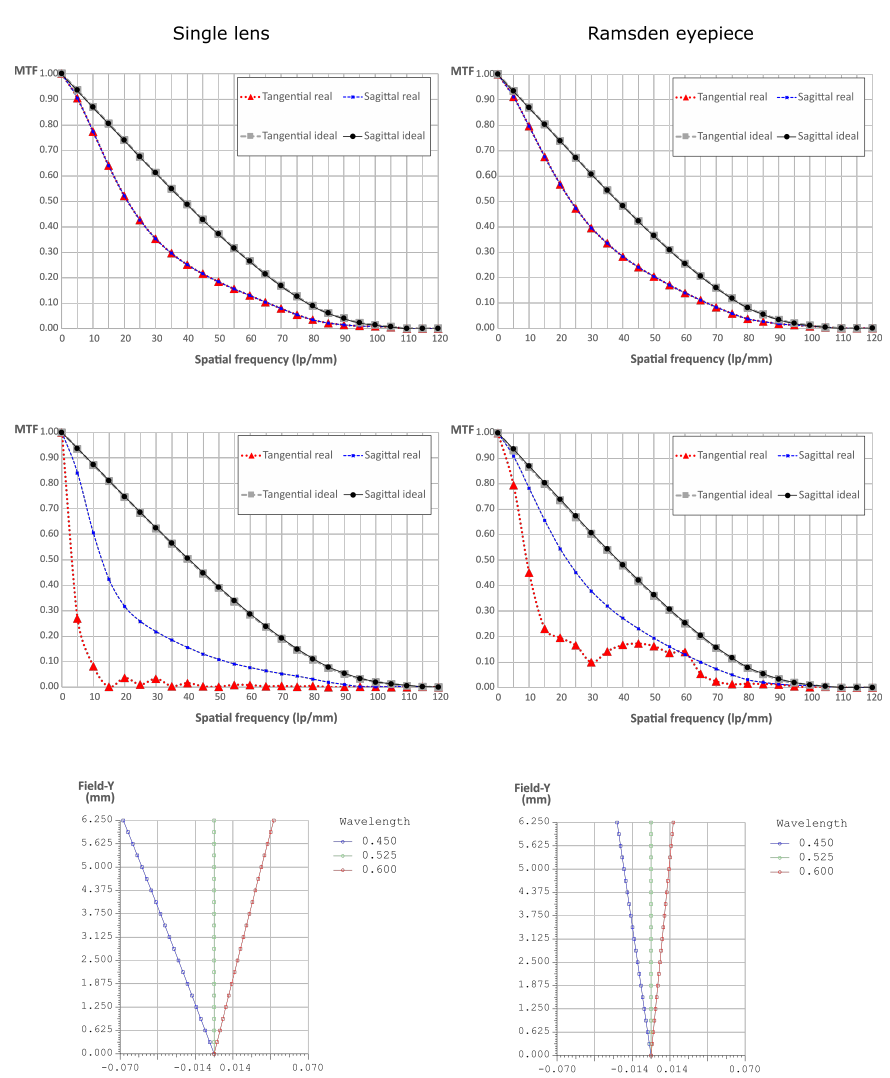
Figure 2. Comparison between two possible eyepiece systems: a single lens and a Ramsden eyepiece. Top line: the MTFs at the center of the FOV. Central line: the MTFs at the edge of the FOV. Bottom line: the lateral color displacement as a function of the lateral displacement in the